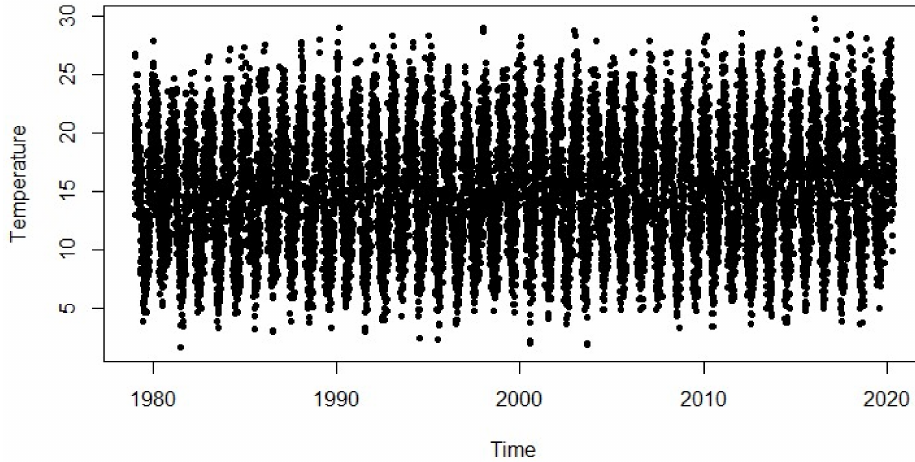
Figure 12. de Doorns ambient temperature 1979–2020 (Temperature in ◦ C).